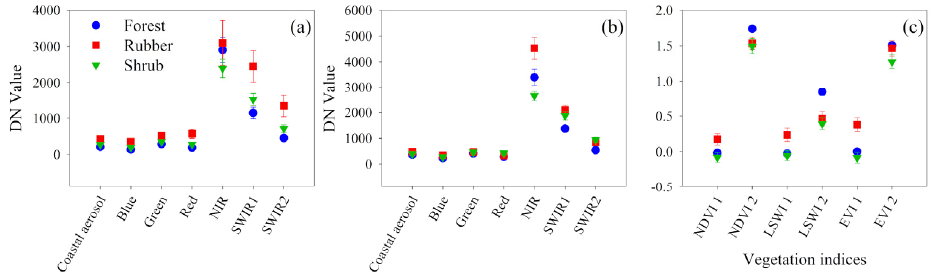
Figure 4. The reflectance of Landsat OLI images with seven spectral bands (coastal aerosol, blue, green, red, NIR, SWIR 1, and SWIR 2) and the six indices based on the NDVI, LSWI, and EVI of natural forests (Forest), rubber plantations (Rubber), and shrublands (Shrub) during the rubber defoliation and refoliation stages. Based on the temporal profile of vegetation indices, the Landsat OLI image in 7 February 2019 was selected for signature analysis of the defoliation: ( a ), the Landsat OLI image in 12 April 2019 was selected for that of the refoliation; ( b ), the six indices based on of the NDVI, LSWI, and EVI in the two different stages of natural forest, rubber plantations and shrub- lands; ( c ), NDVI1 is NDVI refoliation − NDVI defoliation , NDVI2 is NDVI refoliation + NDVI defoliation , LSWI1 is LSWI refoliation − LSWI defoliation , LSWI2 is LSWI refoliation + LSWI defoliation , and EVI1 is EVI refoliation − EVI defoliation , EVI2 is EVI refoliation + EVI defoliation .